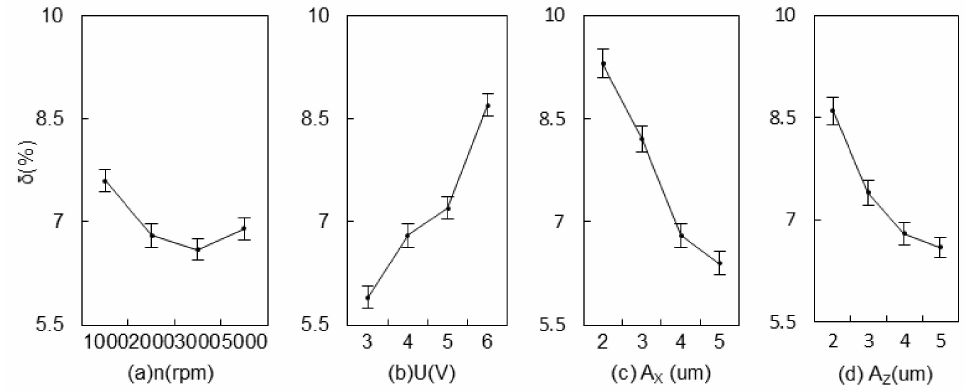
Figure 13. Effects of machining parameters on δ .